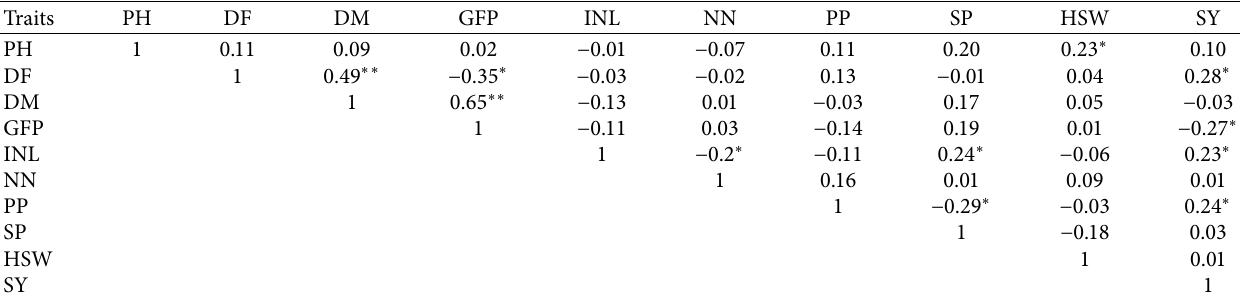
Table 6: Phenotypic correlation coefcient between diferent yields-related traits at Melkassa during 2018 cropping season.